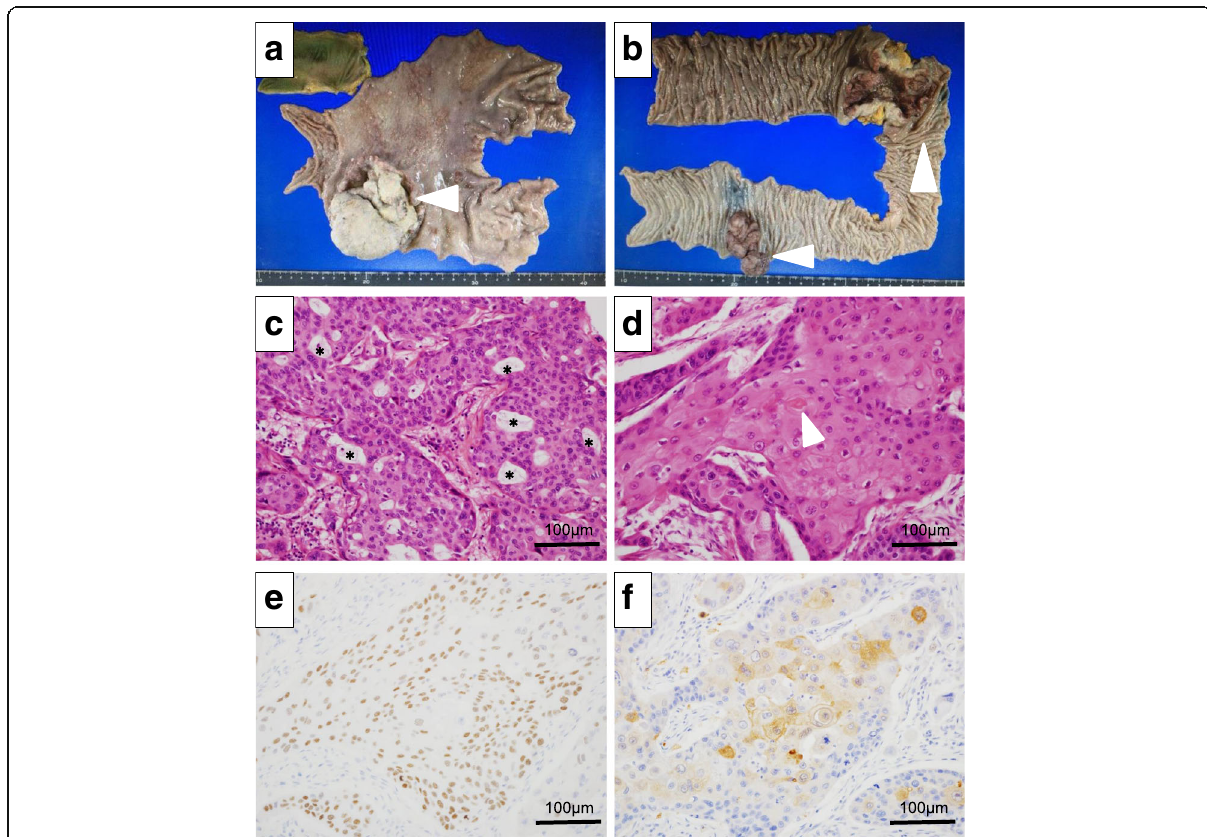
Fig. 3 Histopathology of gastric adenosquamous carcinoma. a Gross specimen of gastric cancer. b Gross specimen of sigmoid colon cancer and descending colon cancer. c Glandular structure ( asterisk ) showing adenocarcinoma components (hematoxylin and eosin staining, ×200 magnification). d Single-cell keratinization showing squamous cell carcinoma components (hematoxylin and eosin staining, 200× magnification) ( white arrow head ). e Immunohistochemical staining for p40 ( e , ×200 magnification). f Staining for G-CSF ( f , ×200 magnification) is positive in the